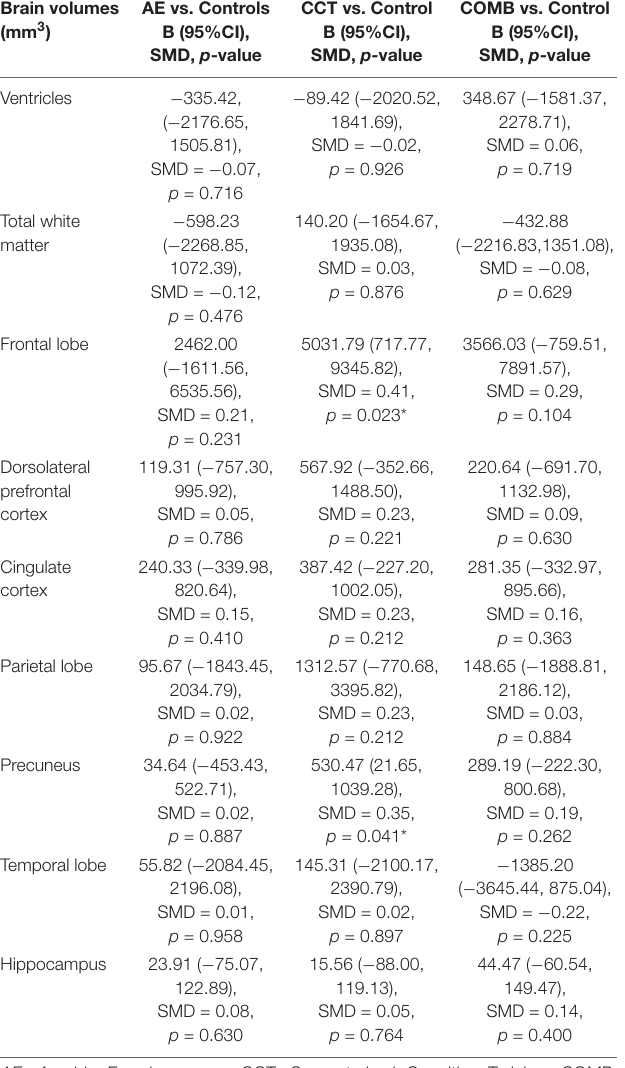
TABLE 4 | Intervention related changes in brain volumes (Level 2).